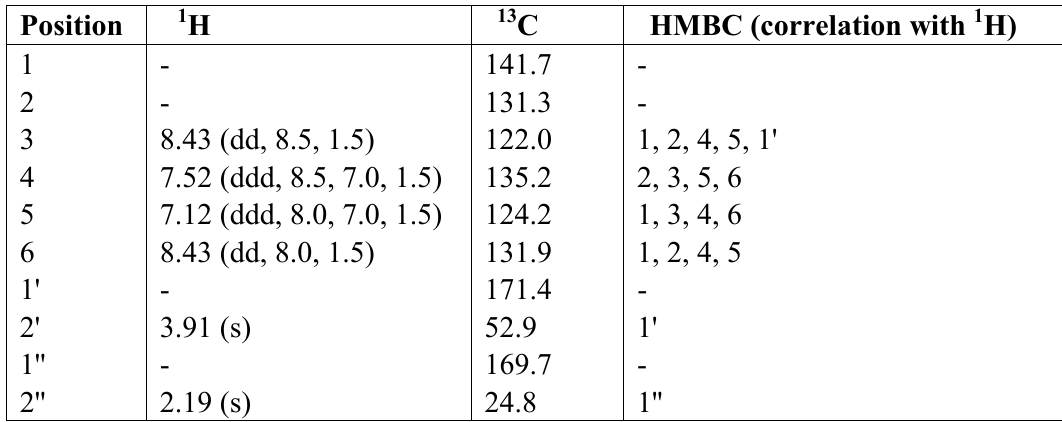
Table 2. 1 H- (500 MHz) and 13 C-NMR (125 MHz) data of 2 (CD ppm) and HMBC